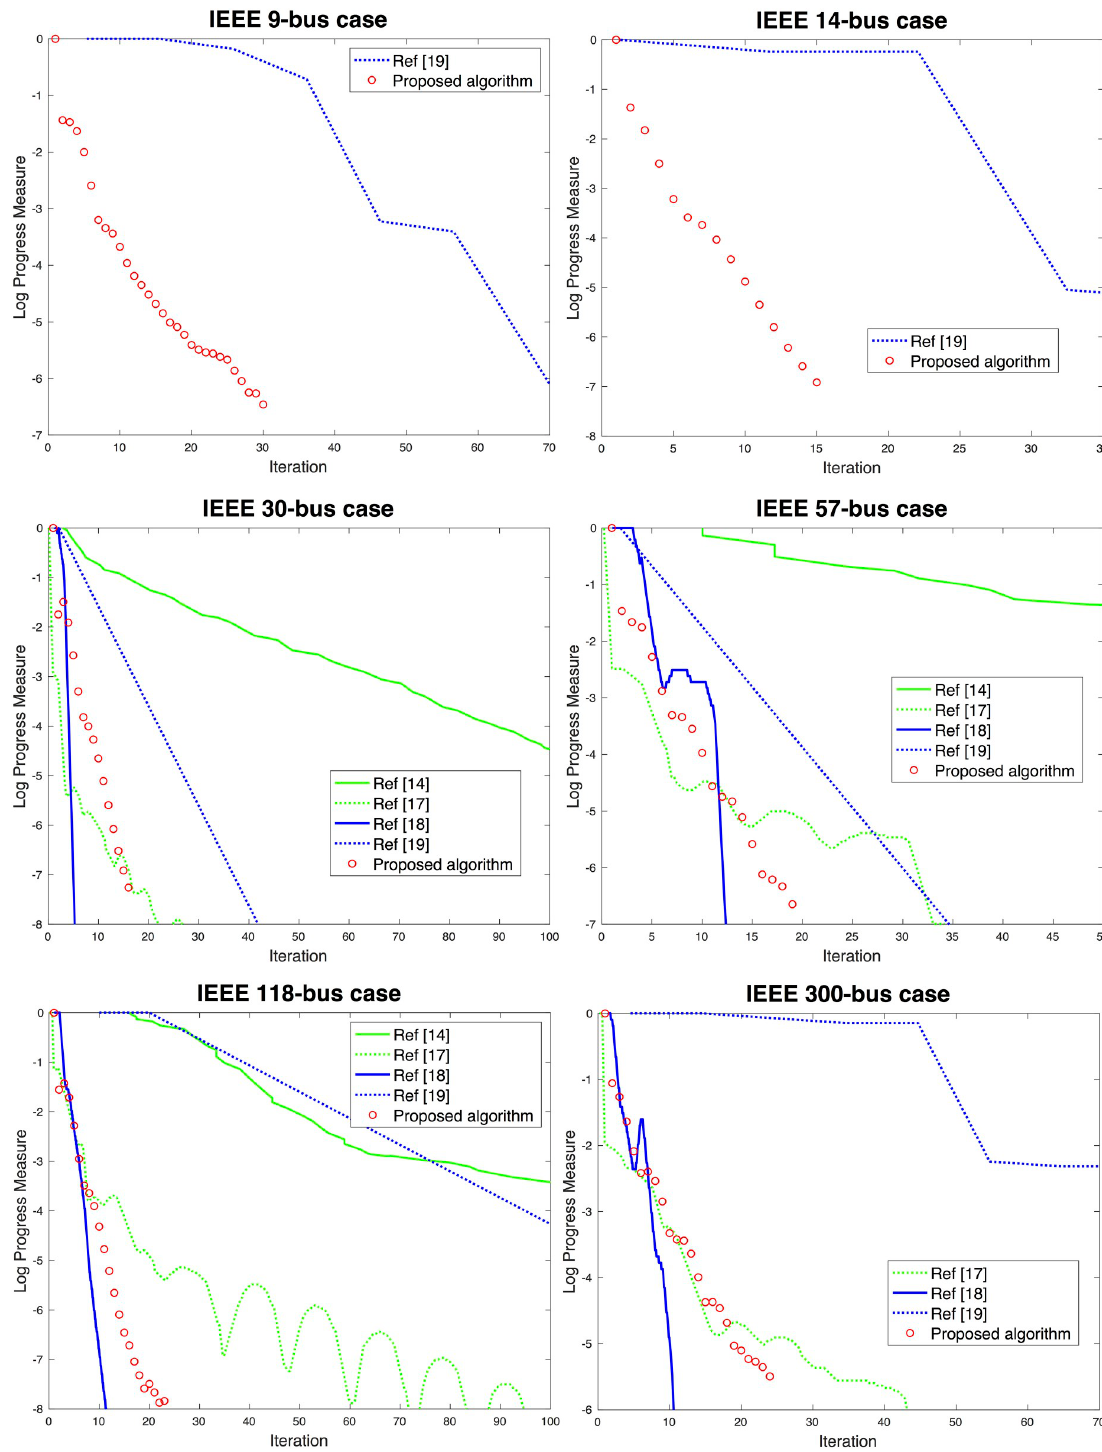
Fig 7. Convergence of proposed algorithm for selected small systems (i.e., IEEE 9-, 14-, 30-, 57-, 118-, and 300-bus systems). The convergences of the ADMM approaches [14, 17–19], are compared.